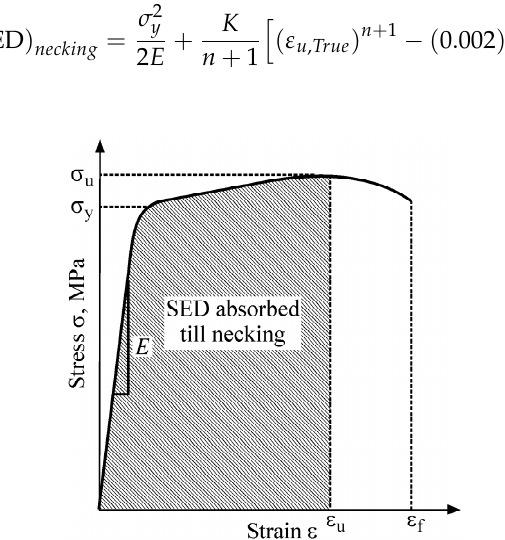
Figure 3. Schematic of a typical stress-strain curve for a ductile material. Reproduced with permission from Torabi, A.R.; Berto, F.; Campagono, Phys. Mesomech. Published by Springer, 2016 [28].